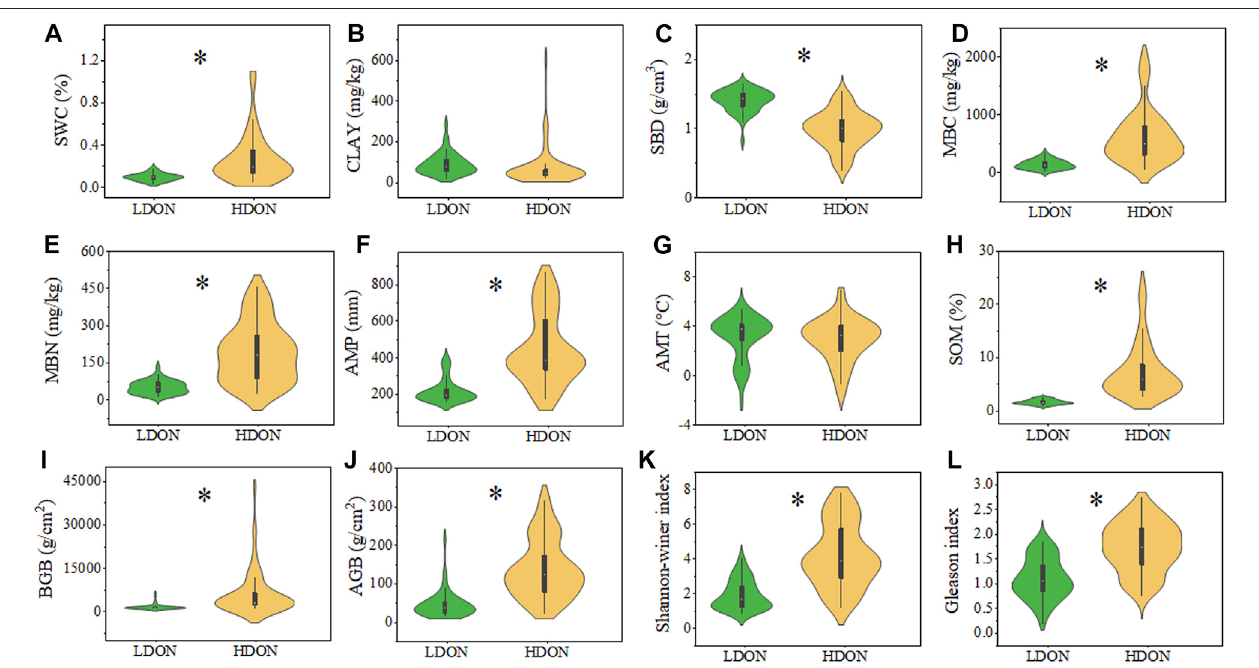
FIGURE 2 | Violin plots showing changes in the (A) soil water content (SWC), (B) soil clay (CLAY), (C) soil bulk density (SBD), (D) microbe biomass carbon (MBC), (E) microbe biomassnitrogen (MBN), (F) annualmeanprecipitation(AMP). (G) annual meantemperature (AMT), (H) soil organicmatter (SOM), (I) belowgroundbiomass (BGB), (J) aboveground biomass (AGB), (K) community diversity of Shannon – Wiener (Shannon),and (L) plant diversity of Gleason (Gleason) in different patterns. “ * ” indicates signi fi cant differences between different patterns.